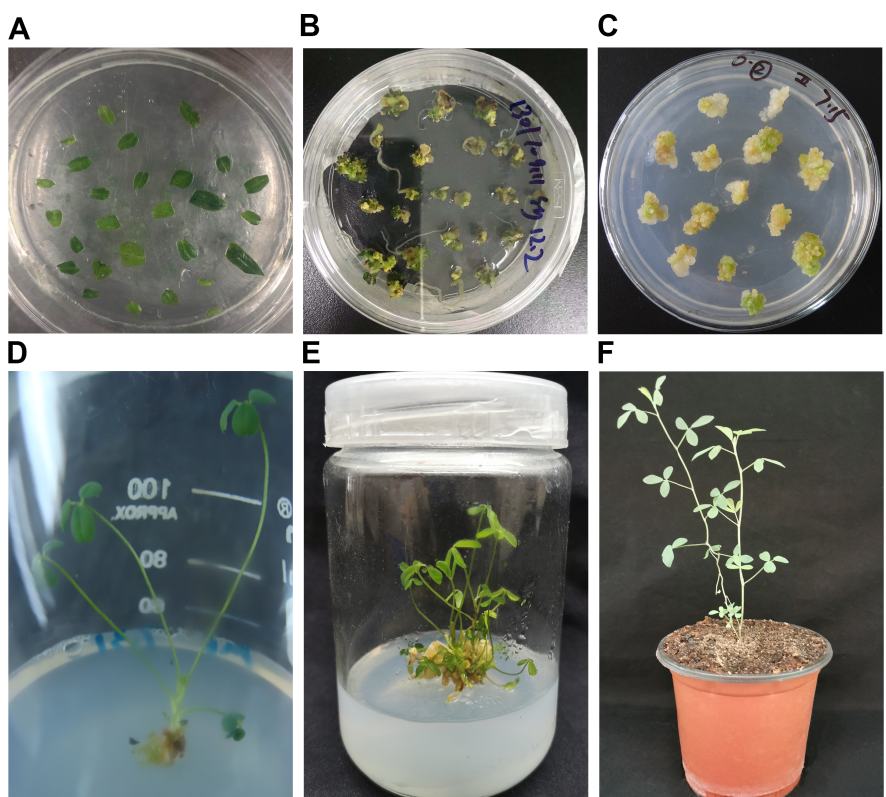
Figure 1. Genetic transformation of ScABI3 in alfalfa. ( A ) Ten-day-old transformed alfalfa leaves cultured on MS medium. ( B ) Calli grown on callus-inducing medium for four weeks. ( C ) Young shoots cultured on a callus differentiation medium for six weeks. ( D ) Seedlings grown on rooting medium for five weeks. ( E ) Seedlings grown on rooting medium for eight weeks. ( F ) Regenerated plants grown in sterilized soil for six weeks.